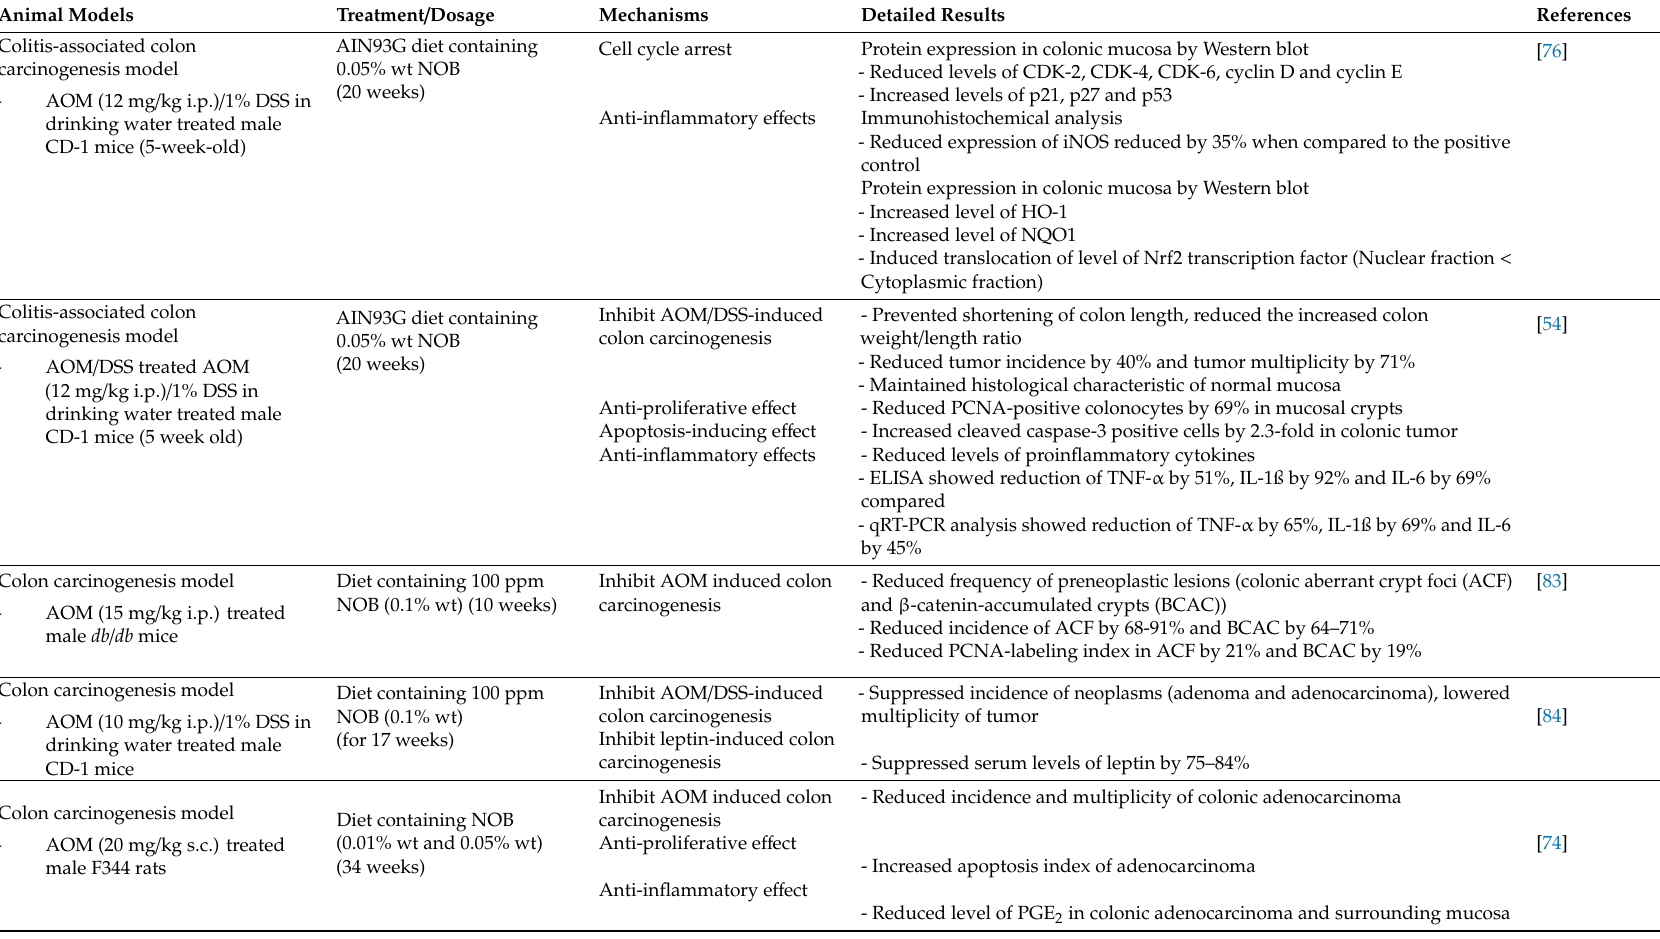
Table 2. In vivo studies of NOB for colon cancer